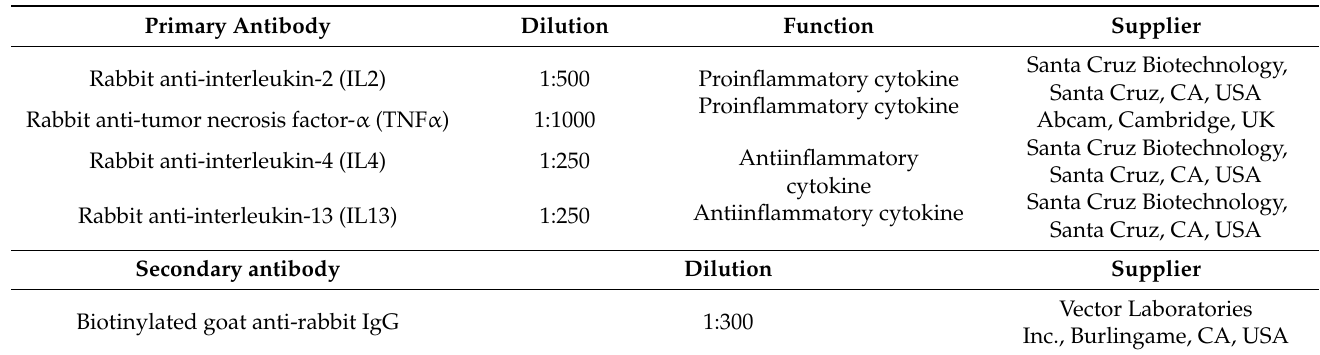
Table 1. Primary and secondary antibodies for immunohistochemical